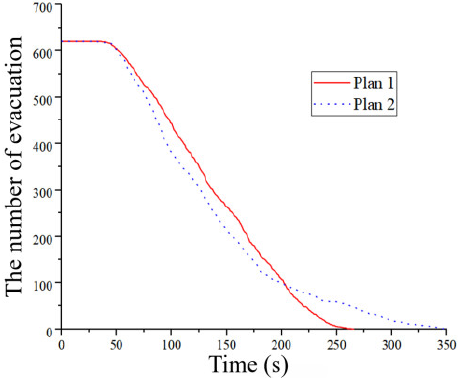
Figure 5. Experimental results of two plans.